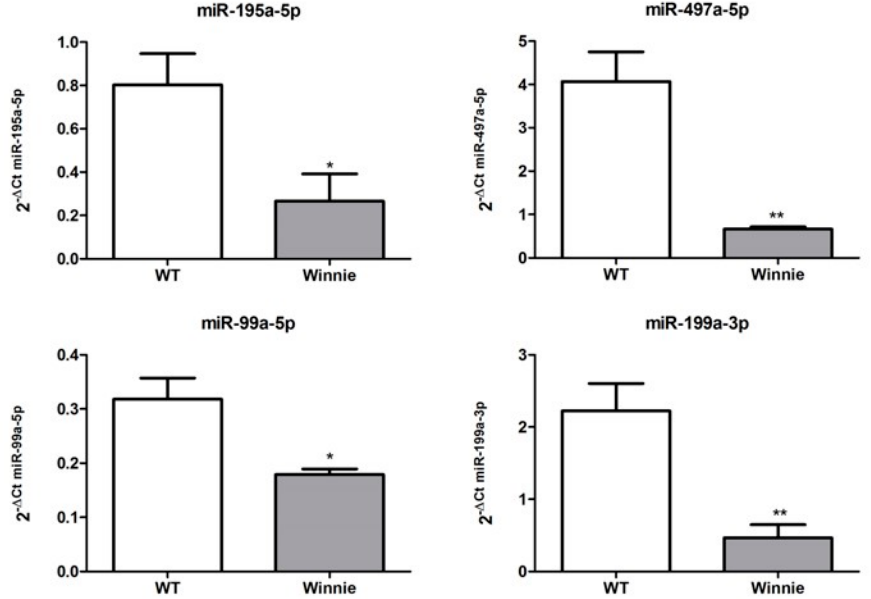
Figure 2. Validation of differentially expressed miRNAs. Expression levels of miR-195a-5p, miR- 497a-5p, miR-99a-5p, and miR-199a-3p on miRNAs isolated from colonic IECs. miRNAs expression levels were quantified using qRT-PCR and the relative expression was normalized to the expression of endogenous control miR-186-5p. All tested miRNAs showed a significant change in expression, confirming microarray data. * p < 0.05; ** p <